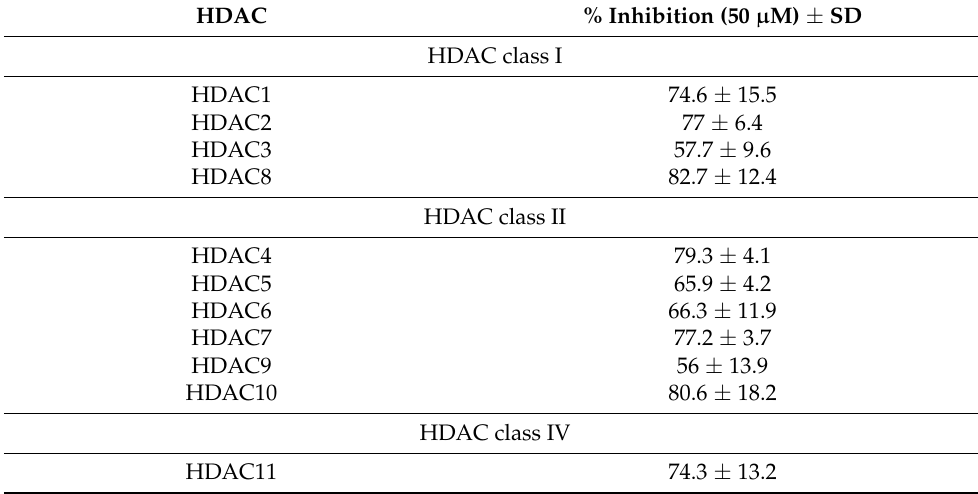
Table 1. Gossypol-induced inhibition of individual HDAC